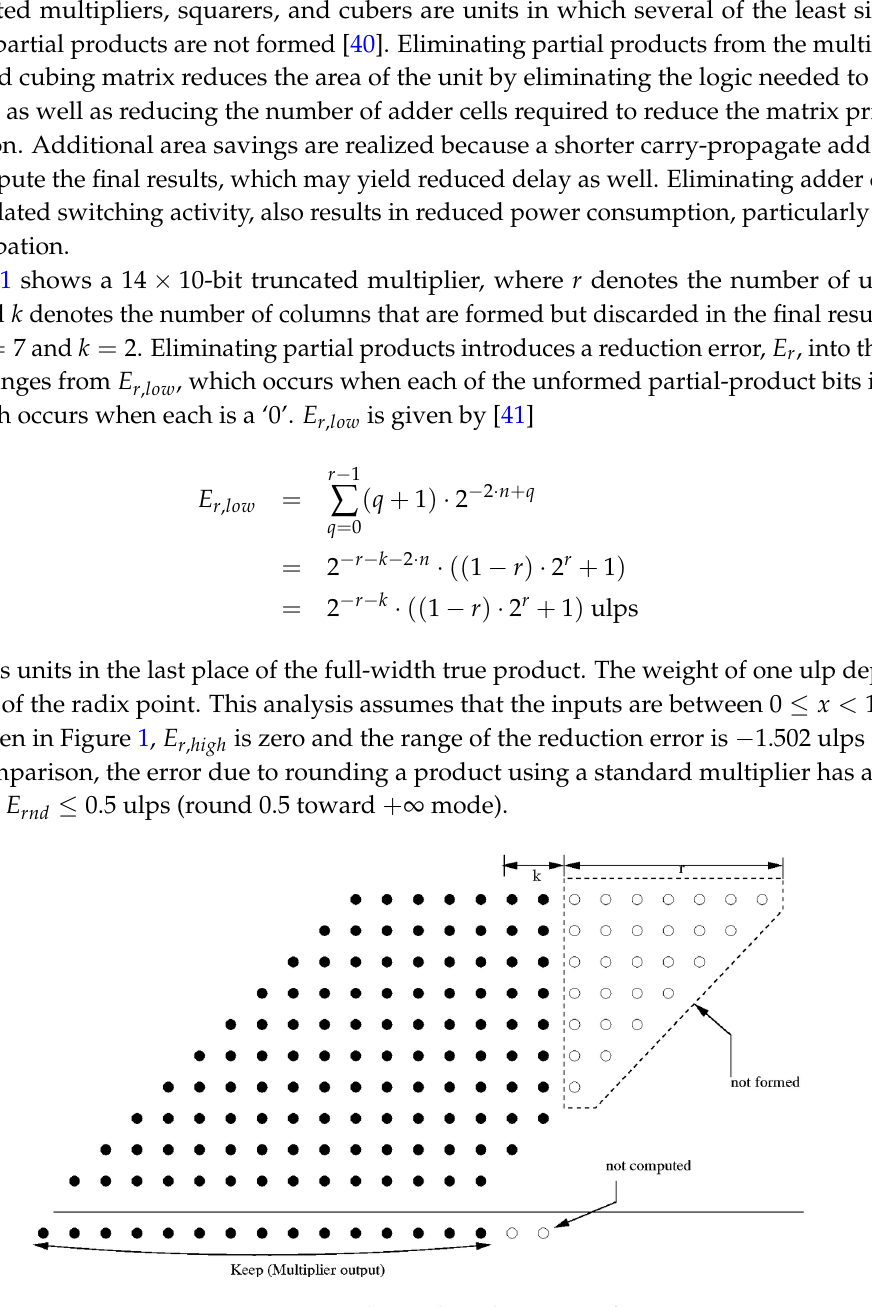
Figure 1. 14 × 10 truncated partial-product matrix, k = 2, r =